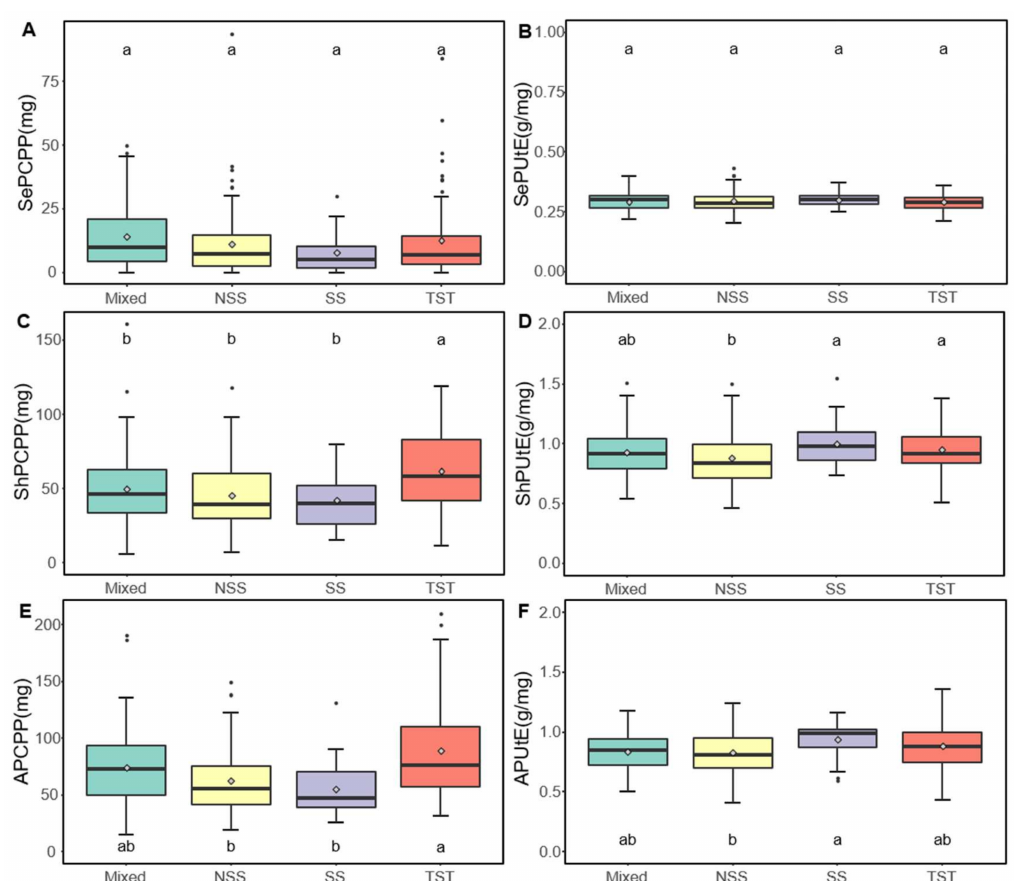
Figure 3. Boxplots for the performance of the four subgroups for six traits under low-P conditions. ( A ) SePCPP. ( B ) SePUtE. ( C ) ShPCPP. ( D ) ShPUtE. ( E ) APCPP. ( F ) APUtE. These four subpopulations are mixed ( n = 101), non-stiff stalk (NSS, n = 118), stiff stalk (SS, n = 29), tropical/subtropical (TST, n = 111). Multiple comparisons were conducted by the LSD test method at a 0.05 significance level. Different letters represent significant differences. The rhombus in the boxplot is the mean value. SePCPP: Seed P content per plant; SePUtE: Seed P utilization efficiency; ShPCPP: Shoot P content per